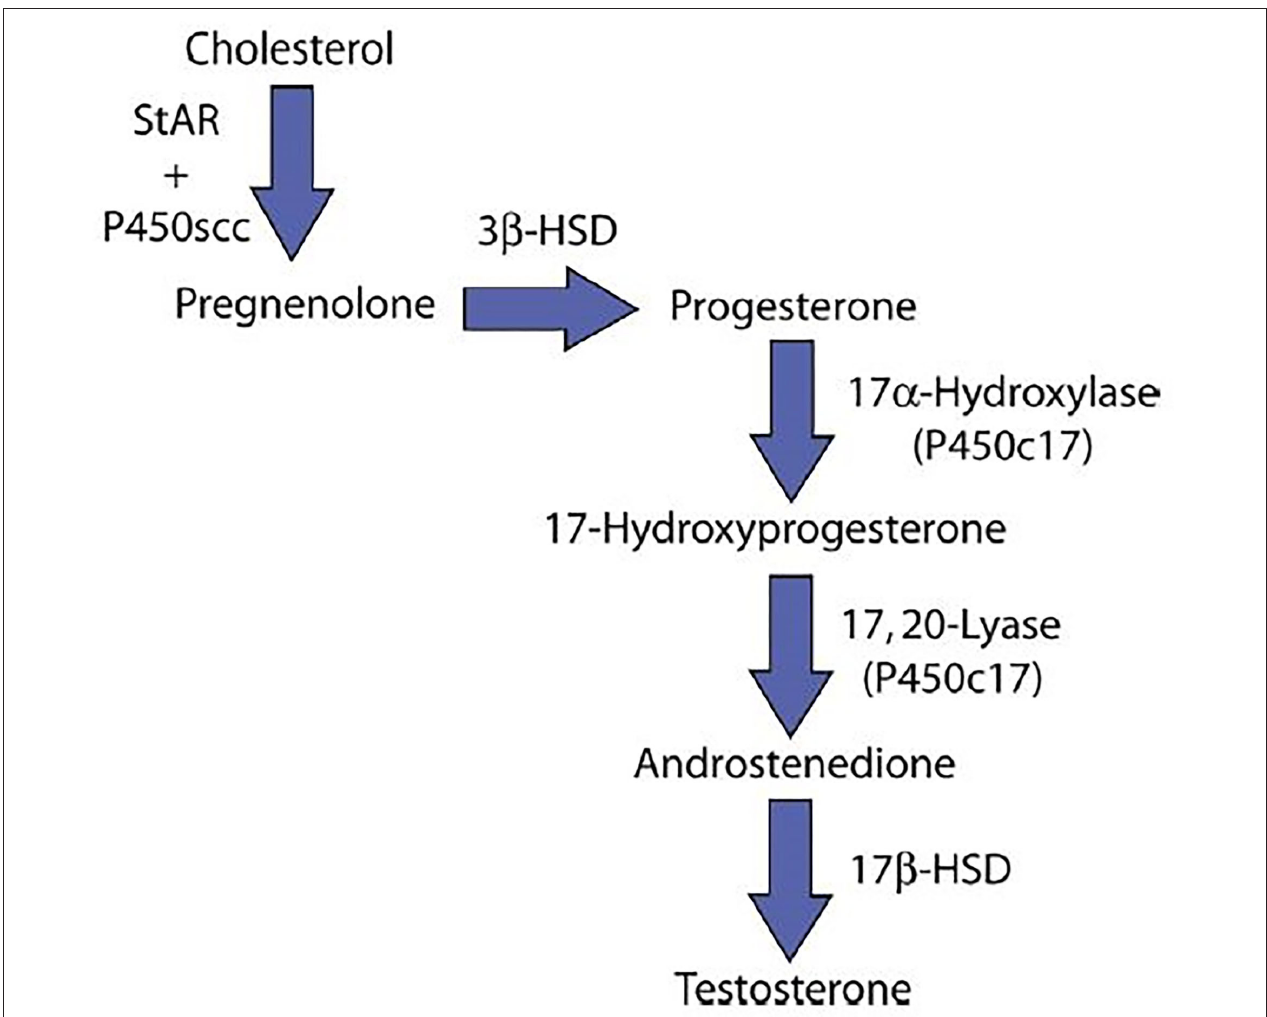
FIGURE 1 | Testosterone synthesis. StAR, steroidogenic acute regulatory protein; P450scc, Cholesterol side-chain cleavage enzyme; 3 β -HSD, 3 β -Hydroxysteroid dehydrogenase; 17 β -HSD, 17 β -Hydroxysteroid dehydrogenase; P450c17, Cytochrome P450 17A1.